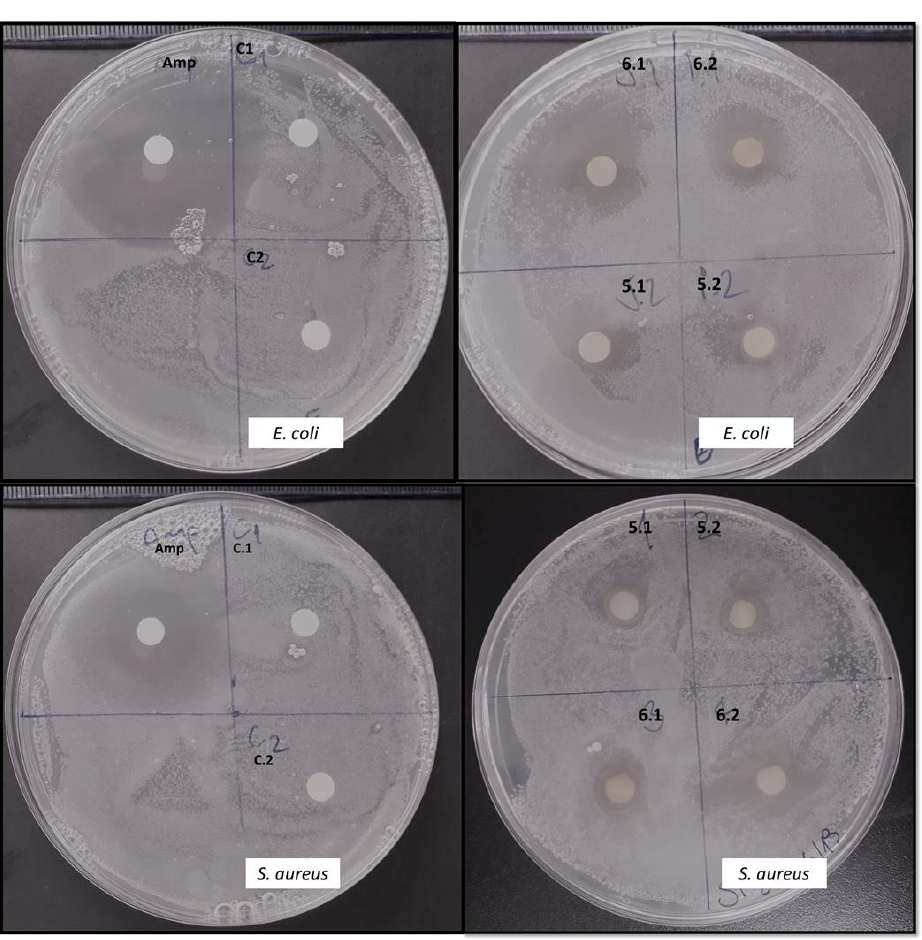
Figure 3. Antibacterial activity of the extract from cultures of R. rubra against Staphylococcus aureus ATCC25923 and Escherichia coli ATCC25922 in Mueller–Hinton agar medium. Amp: ampicillin (positive control); C: LFR (negative control); run 6 and run 5 extract from cultures of R. rubra , 1 and 2 are duplicates of the samples.